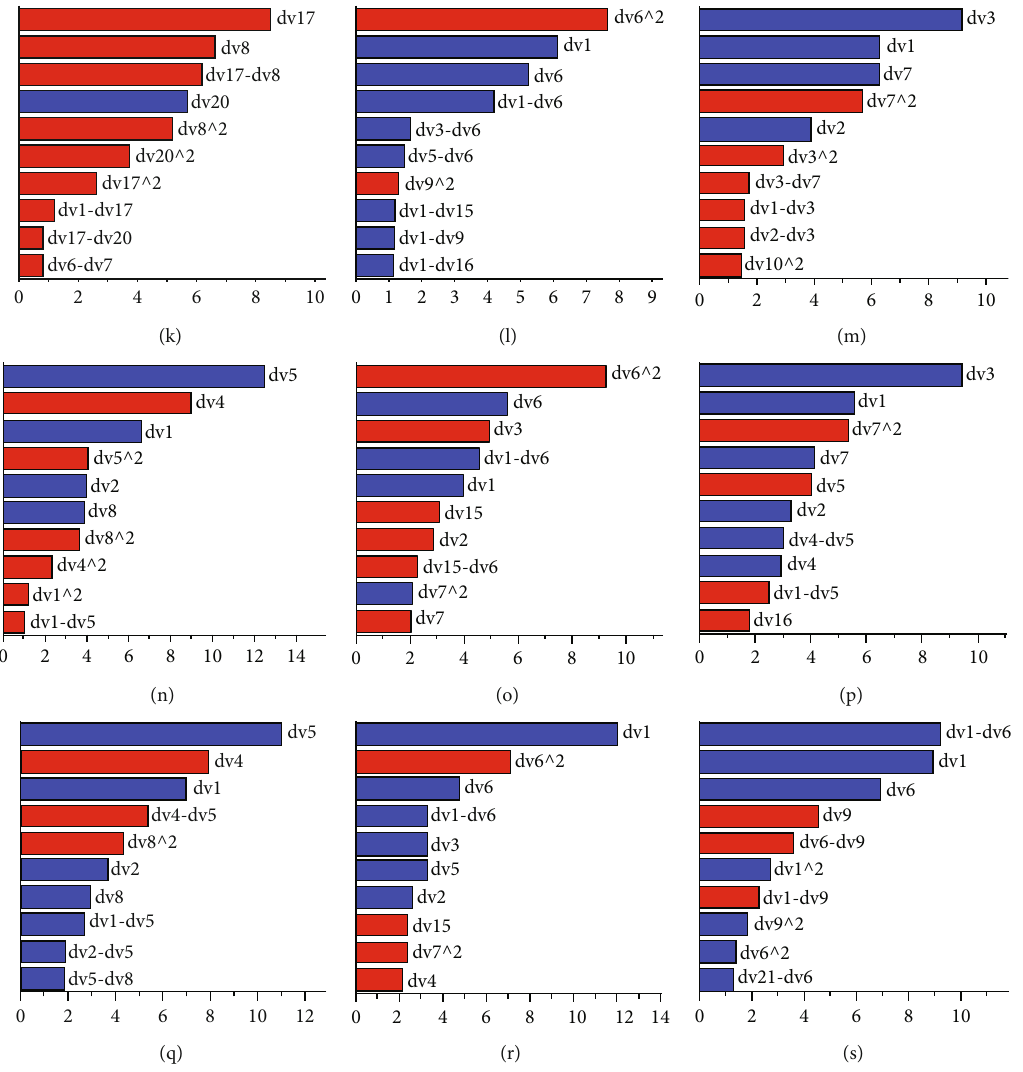
Figure 14: Pareto graphs of the main performance parameters in case A: (a) M